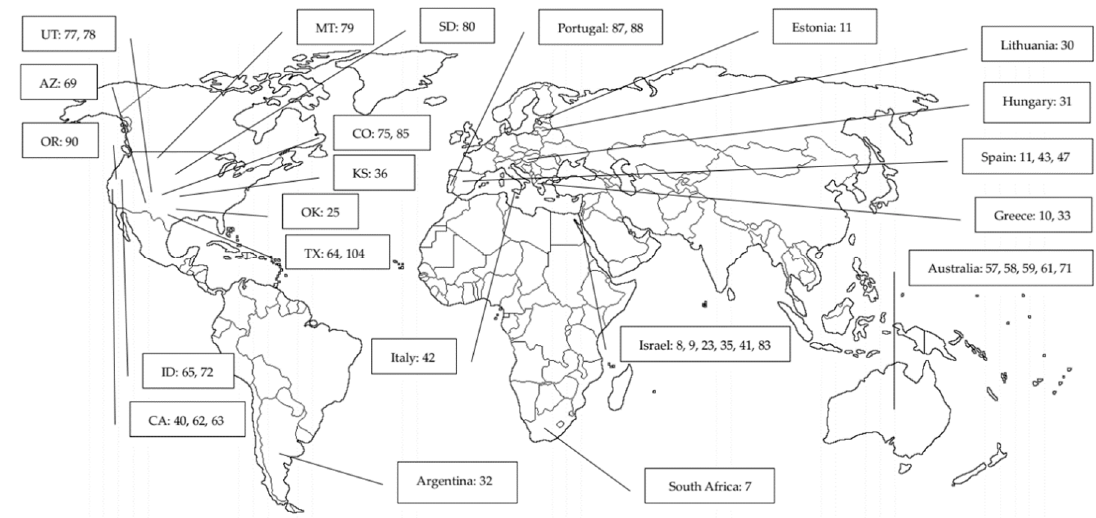
Figure 1. The world map, indicating sites of key studies (for more details, follow the numbers in the list of references).